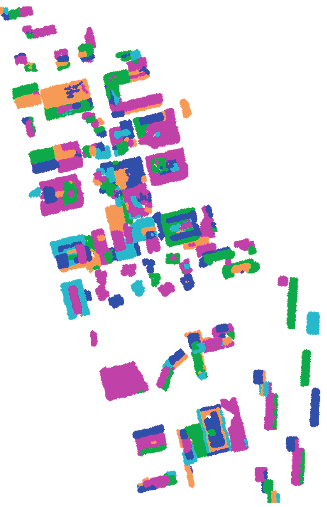
Figure 21. 3D building models of the Tapiola area.